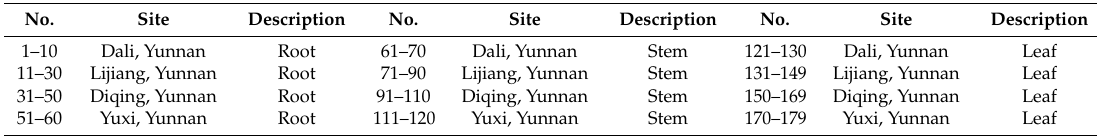
Table 7. Information of G. rigescens.